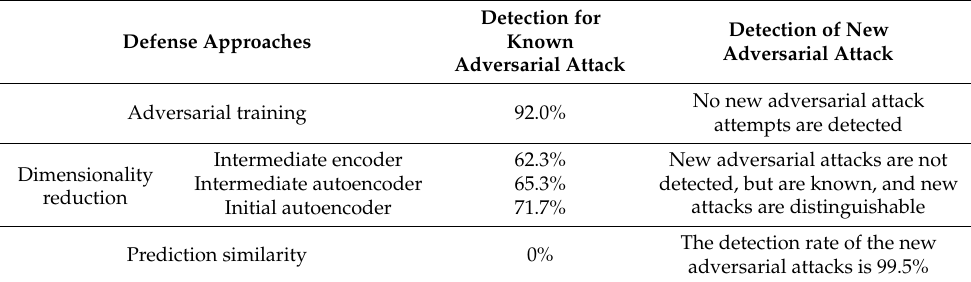
Table 8. Impacts of known and new adversarial attack on three defense